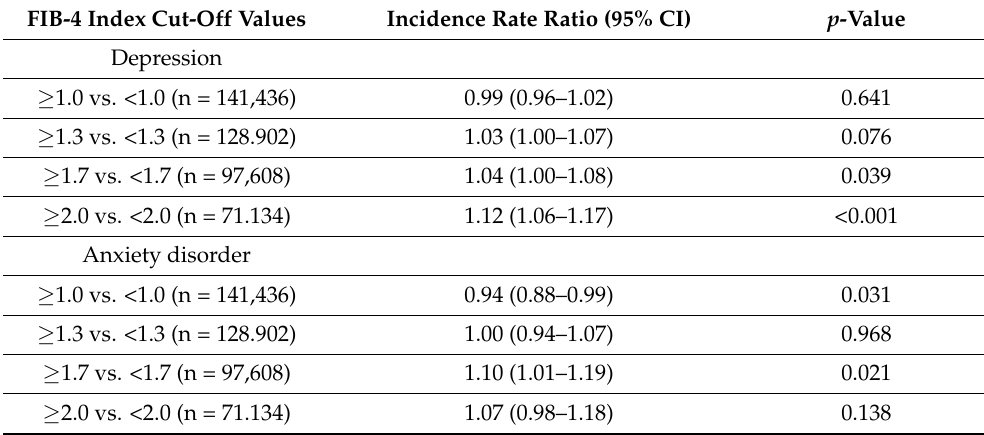
Table 1. Association between the FIB-4 index and incidence of depression and anxiety disorder within 10 years from index date in patients followed in general practices in Germany depending on different FIB-4 index cut-off values (univariable Poisson regression models).